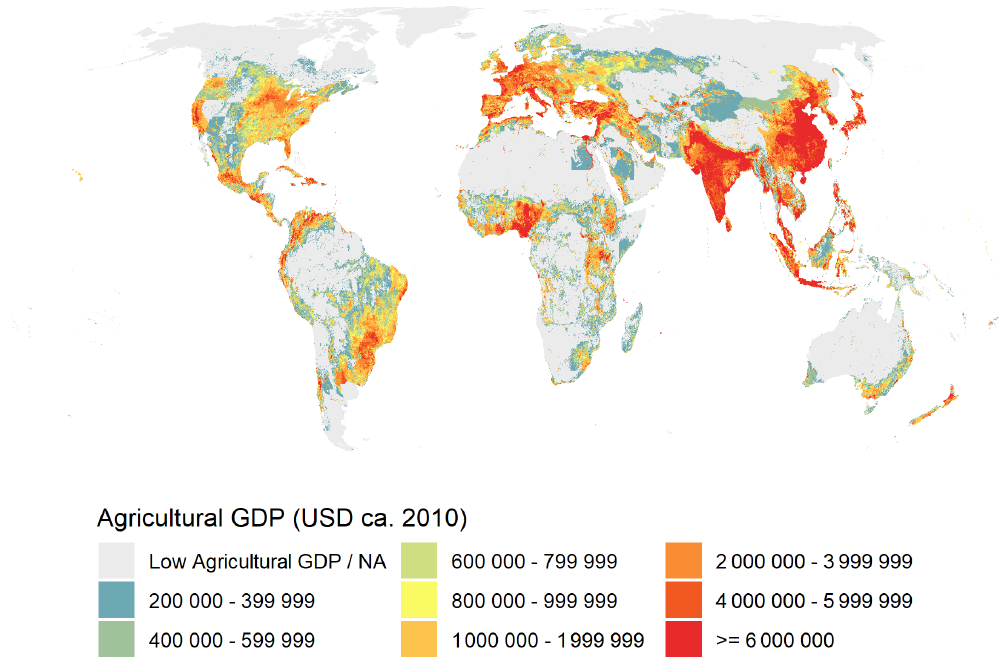
Figure 5. Global gridded AgGDP circa 2010 from the cross-entropy model in 2010 USD. Table 2. Spearman correlation of AgGDP with nighttime lights at the Admin 0 level (1) and Admin 2 level (2) as well as the rural populations at the Admin 0 level (3) and Admin 2 level (4), grouped by World Bank region where AFR is sub-Saharan Africa, EAP is East Asia and the Pacific, ECA is eastern Europe and central Asia, LAC is Latin America, MENA is the Middle East and North Africa, SOA is South Asia, and Other is the category for the remaining countries (NOAA, 2011; World Bank,